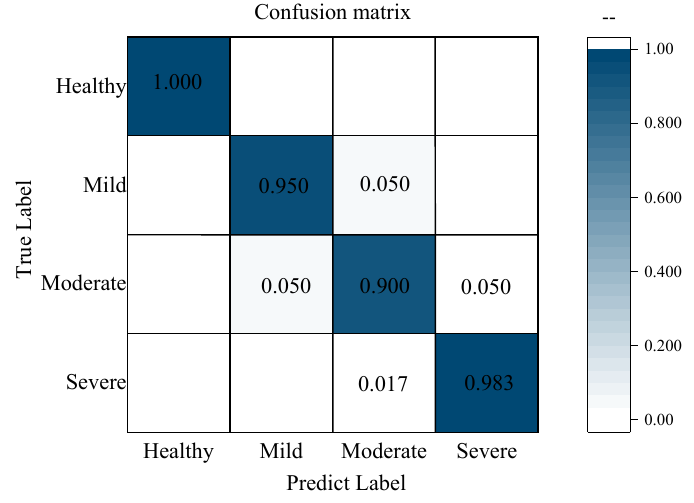
Figure 8. Confusion matrix of overall prediction results for all samples.